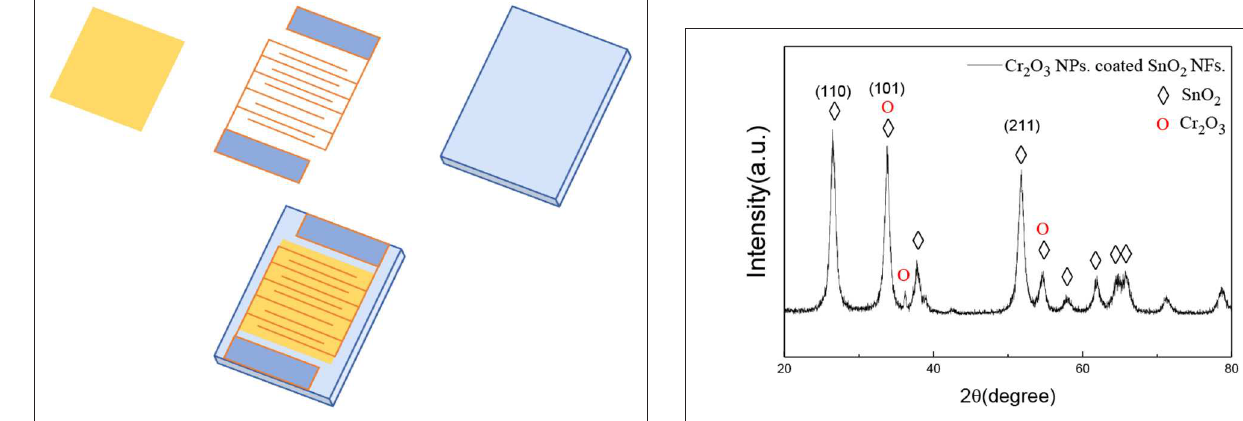
FIGURE 2 | The XRD spectrum of Cr 2 O 3 NPs. coated SnO 2